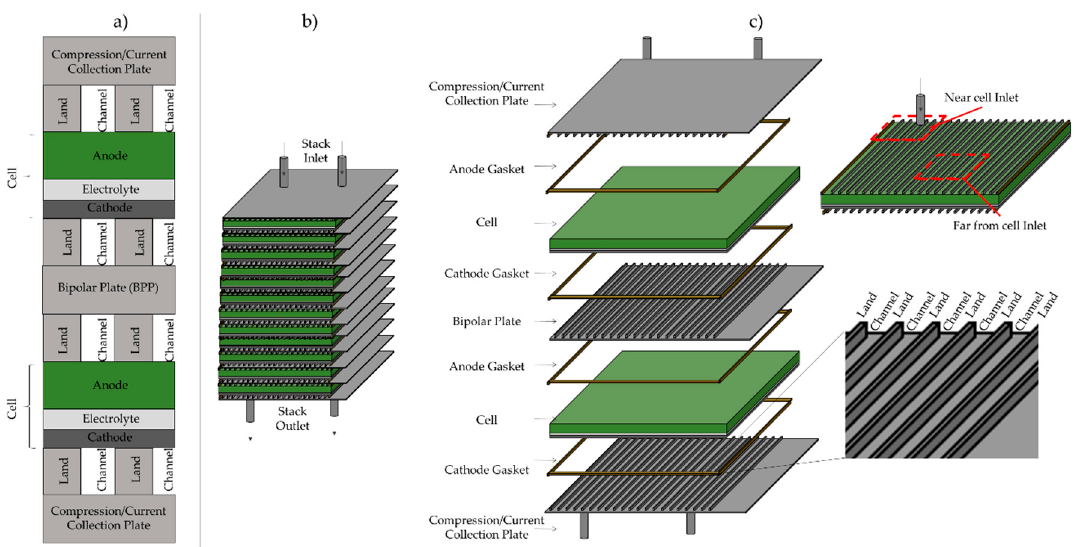
Figure 1. Illustrations of a solid oxide fuel cell (SOFC) stack: ( a ) the cross-section from a stack composed of two cells simplified in 2D; ( b ) a twelve cell stack in 3D; and ( c ) an exploded image of a two cell stack, with magnification of the cell surface and gas channels. Note that the stack investigated in this work comprised 30 cells.